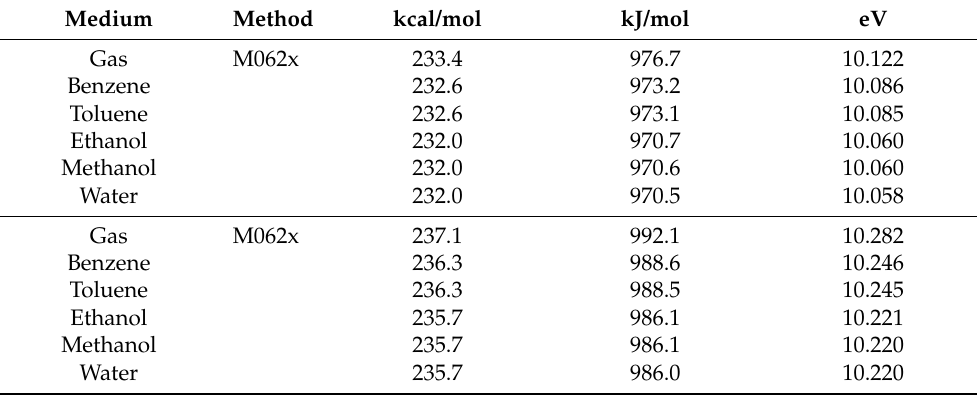
Table 6. Ionization enthalpies (IP H ) of the H-atom in common environments (poorly) approximated as Kohn–Sham HOMO energy with reversed sign (Koopmans’ theorem). Results using Minnesota functionals M062x and M052x and basis sets 6-31+G(d,p).